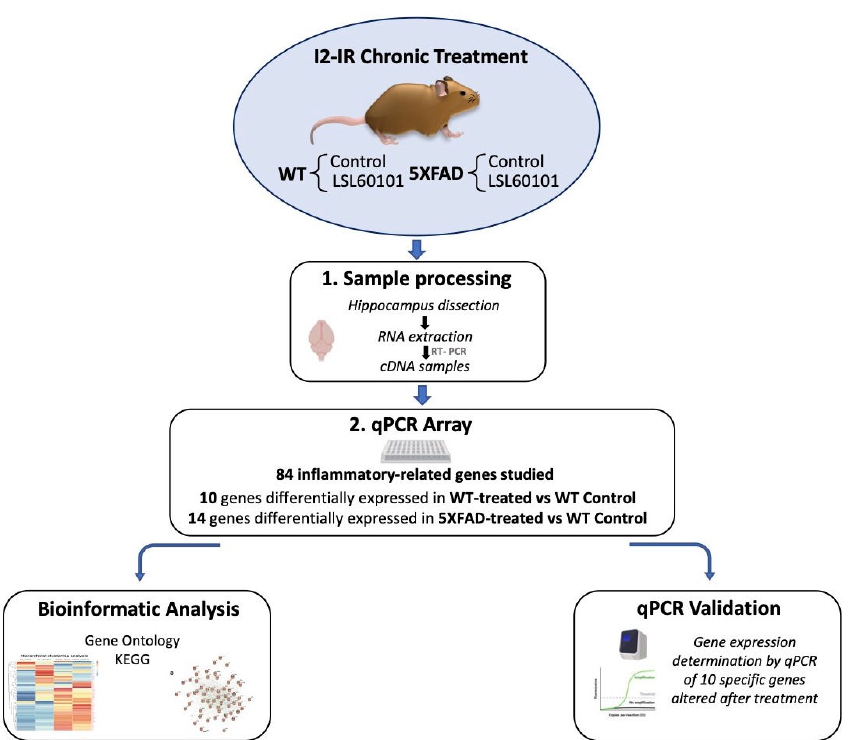
Figure 1. Experimental design of sampling processing, bioinformatic analysis and qPCR